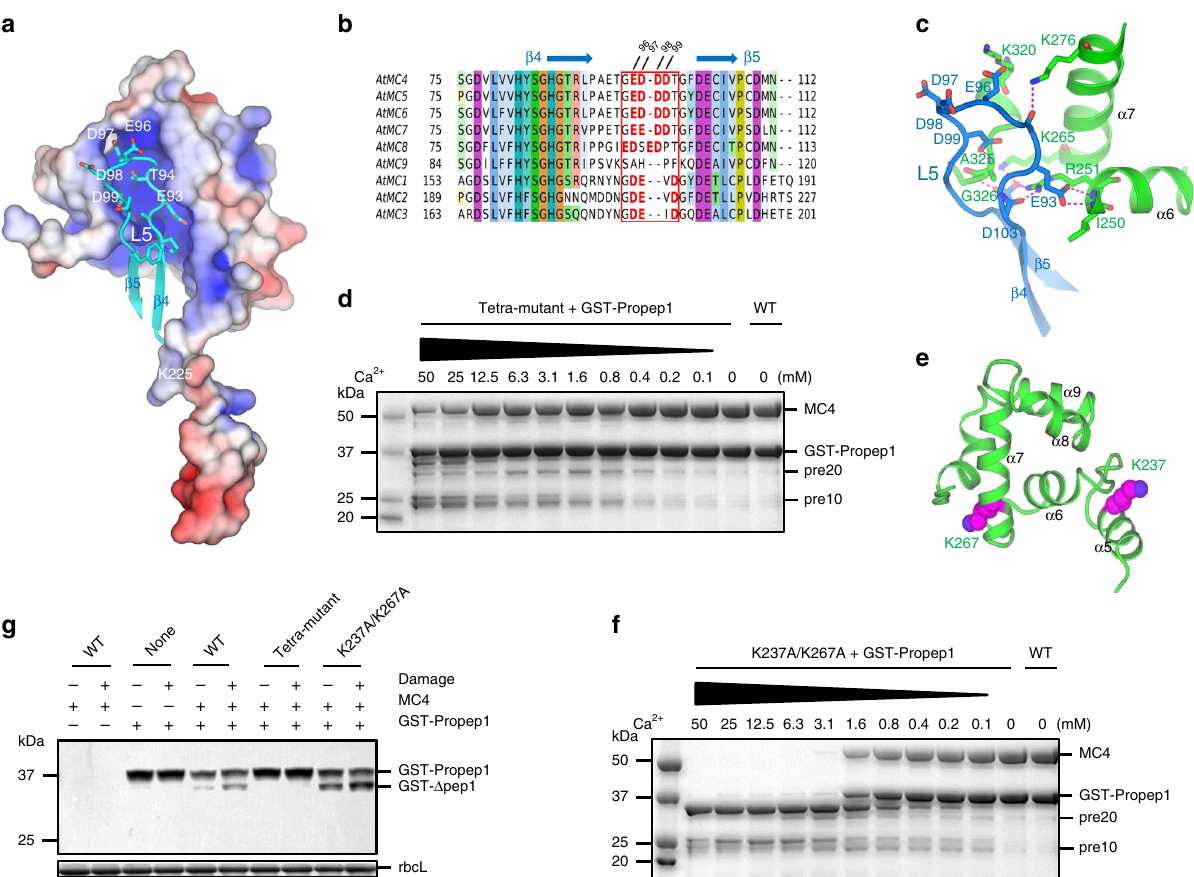
Fig. 3 The roles of L5 loop and two self-cleave sites in the linker-C domain in Ca 2 + -dependent At MC4 activation and substrate processing. a Loop L5 (cyan) is embedded in a positively charged pocket de fi ned by the linker domain. The electrostatics was calculated by using APBS and plotted at the level of ±4 kT/e. b Sequence alignment of nine Arabidopsis metacaspases ( At MCs) for the L5 loop region. Highlighted residues (bold in red) are negatively charged residues present in all At MCs except At MC9 whose activation is Ca 2 + independent. c Interactions of the L5 loop with the linker domain. H-bonds are shown as dashed lines and colored in magenta. d A tetra-mutant (E96A/D97A/D98A/D99A) in the L5 loop is de fi cient to cleave its substrate GST- Propep1 in vitro. e Location of two self-cleavage sites (Lys237 and Lys267) in the α -helical region of the linker domain (linker-C region). f A K237A/K267A double mutant cleaves GST-Propep1 in a less Ca 2 + -dependence in vitro. g In vivo damage-induced GST-Propep1 processing by wild-type At MC4 and its mutants in transfected tobacco leaves. Western blot used anti-GST antiserum. For protein loading control, the blot is stained by Ponceau Red and the band for rbcL is